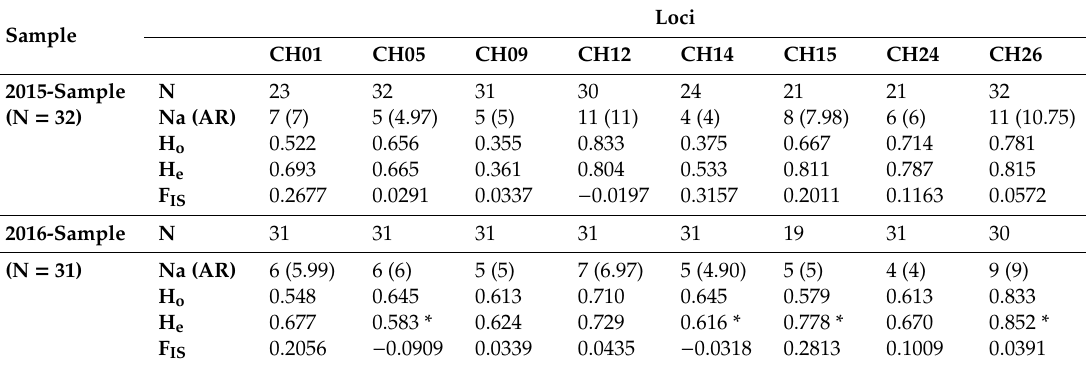
Table 3. Microsatellite genetic diversity for each locus in each NWS fly population. N—sample size; Na—number of alleles per locus; AR—allelic richness; H o —observed heterozygosity; H e